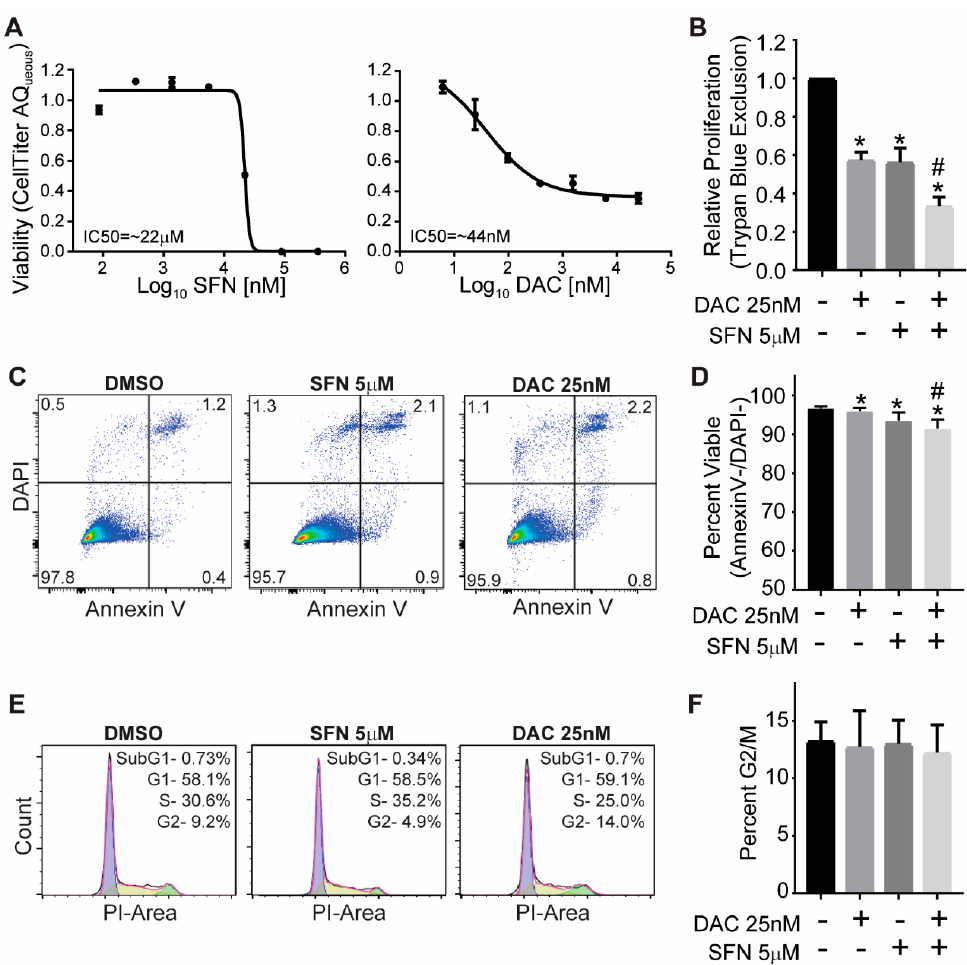
Figure 1. Impact of SFN and DAC single and combination treatment on the growth of B16 melanoma. ( A ) The IC50 of SFN and DAC single treatment is approximately 22 µ M and 44 nM, respectively. Cell viability was determined using the CellTiter 96 AQ ueous One Solution Cell Proliferation kit. The data were analyzed by nonlinear regression to determine the IC50. ( B ) Growth inhibition induced from single and combination treatment of SFN and DAC. Viable cells were measured by trypan blue staining and analyzed by Student’s t -test. ( C ) Representative apoptosis analysis (AnnexinV / DAPI) by flow cytometry from control, SFN, and DAC single treatment. ( D ) The percentage of viable cells with DAC and SFN single and combination treatments were compared to control. ( E ) Representative cell cycle analysis from control and SFN and DAC single treatment. Data were analyzed with Flow Jo / Dean-Jett Fox (DJF) model. ( F ) The percent G2/M phase in DAC and SFN single and combination treatments were compared to control with Student’s t -test. * Significantly different from control, # Single treatment is significantly different from combinational treatment (Student’s t -test).